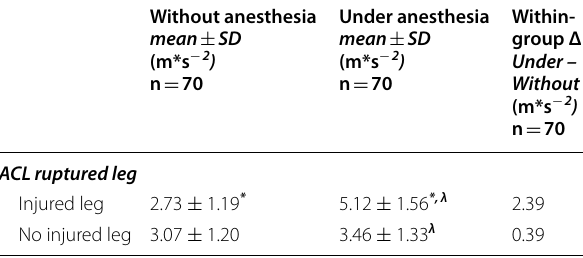
ACL Anterior Cruciate Ligament, SD Standard Deviation, Δ Differences *Within-group statistical significance p < 0.001 λ Between-group statistical significance p <